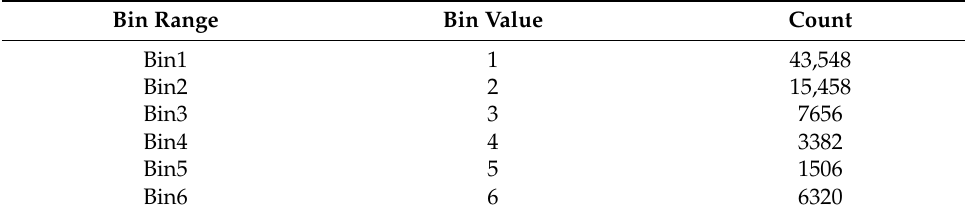
Table 4. Distribution for duration with moving-mean logic.